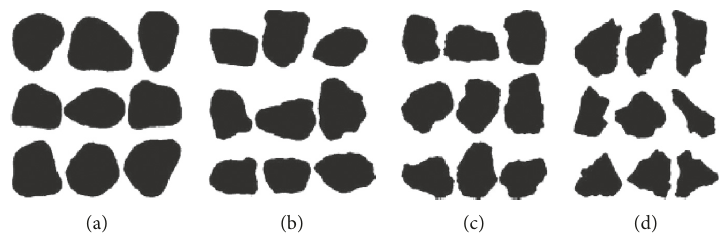
Figure 1: Angularity index for various shapes. (a) 0